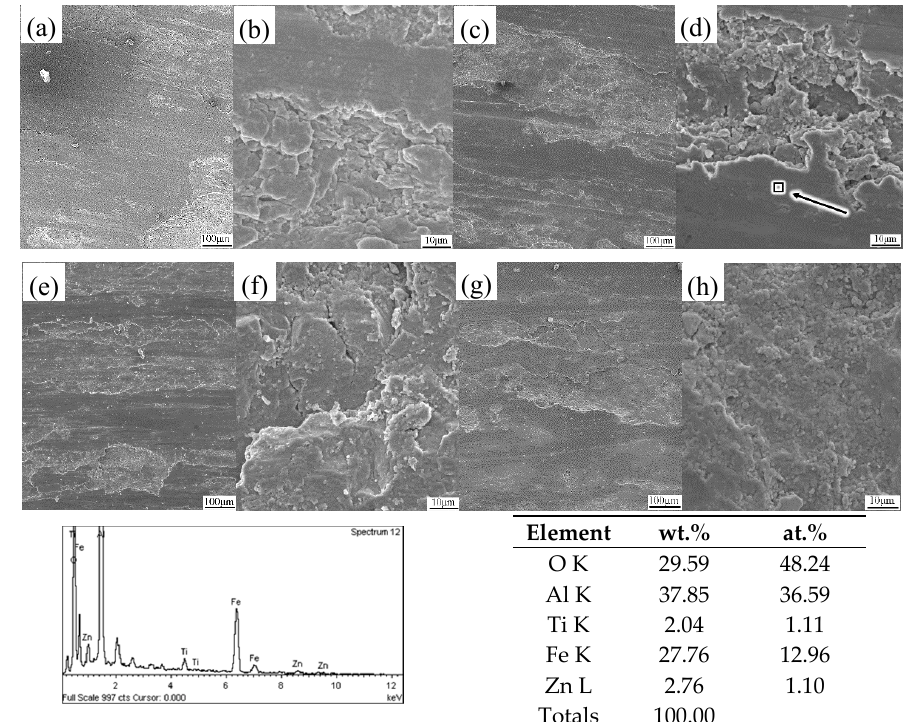
Figure 12. SEM and EDS results of the wear tracks on rheocast 4.5 wt. % TiB 2 /7075 specimens formed under different friction loads: ( a , b ) 30 N, ( c , d ) 60 N, ( e , f ) 90 N, and ( g , h ) 120 N.